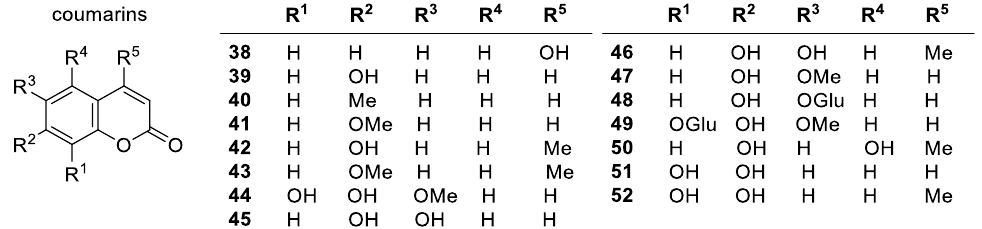
Figure 5. Structure of phenolic antioxidants with a coumarin core.